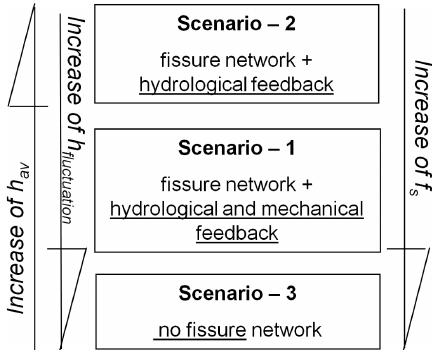
Fig. 11. General trends in groundwater level ( h av ) and local factor of safety ( f s ) when analysing four